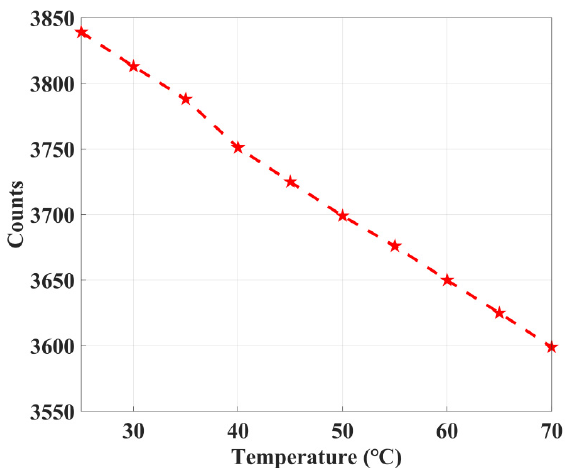
Figure 11. Dependence of ring oscillator frequencies on temperature.